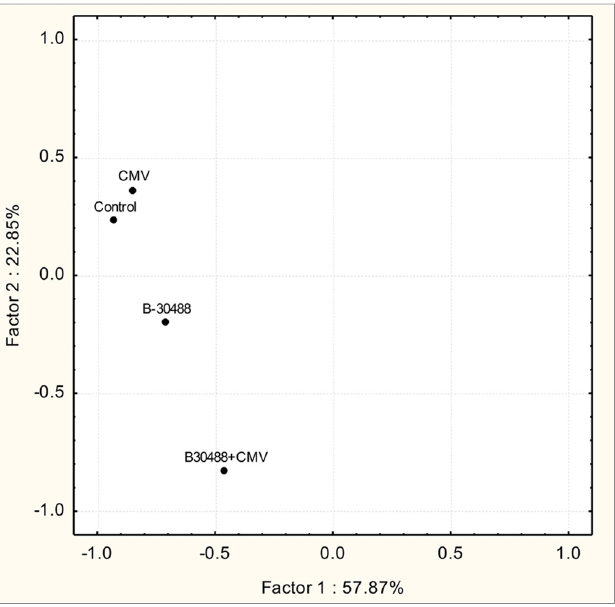
Fig 6. B-30488 enhanced the colonization of beneficial population in tobacco roots. Principal component analysis of carbon source utilization by rhizosphere microbial community of control; B-30488; CMV and B-30488+CMV tobacco plants using Biolog Eco Plates.